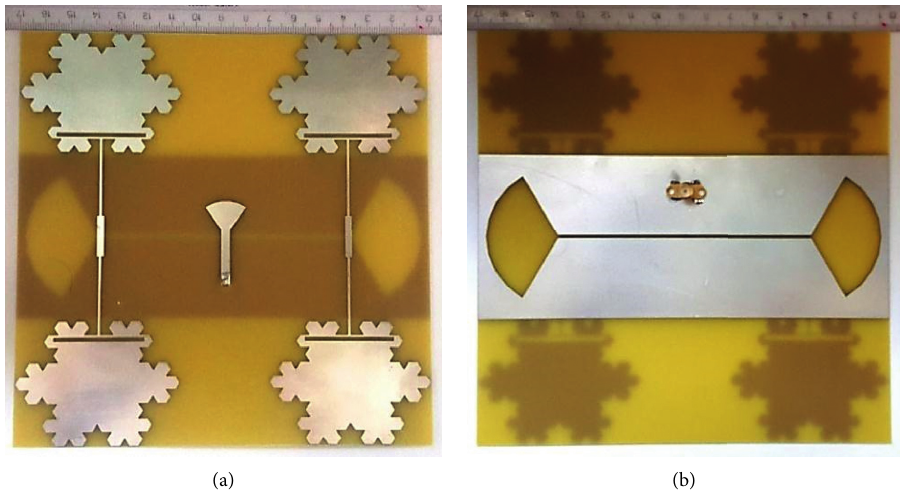
Figure 5: Prototype of the fractal monopole antenna array. (a) Top view. (b) Bottom view.